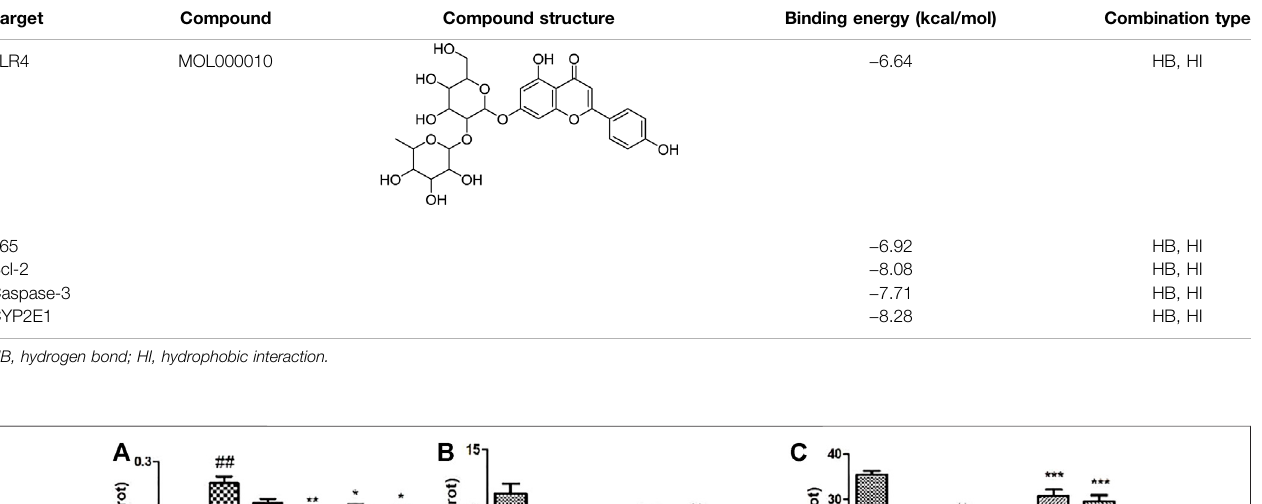
Frontiers in Pharmacology |